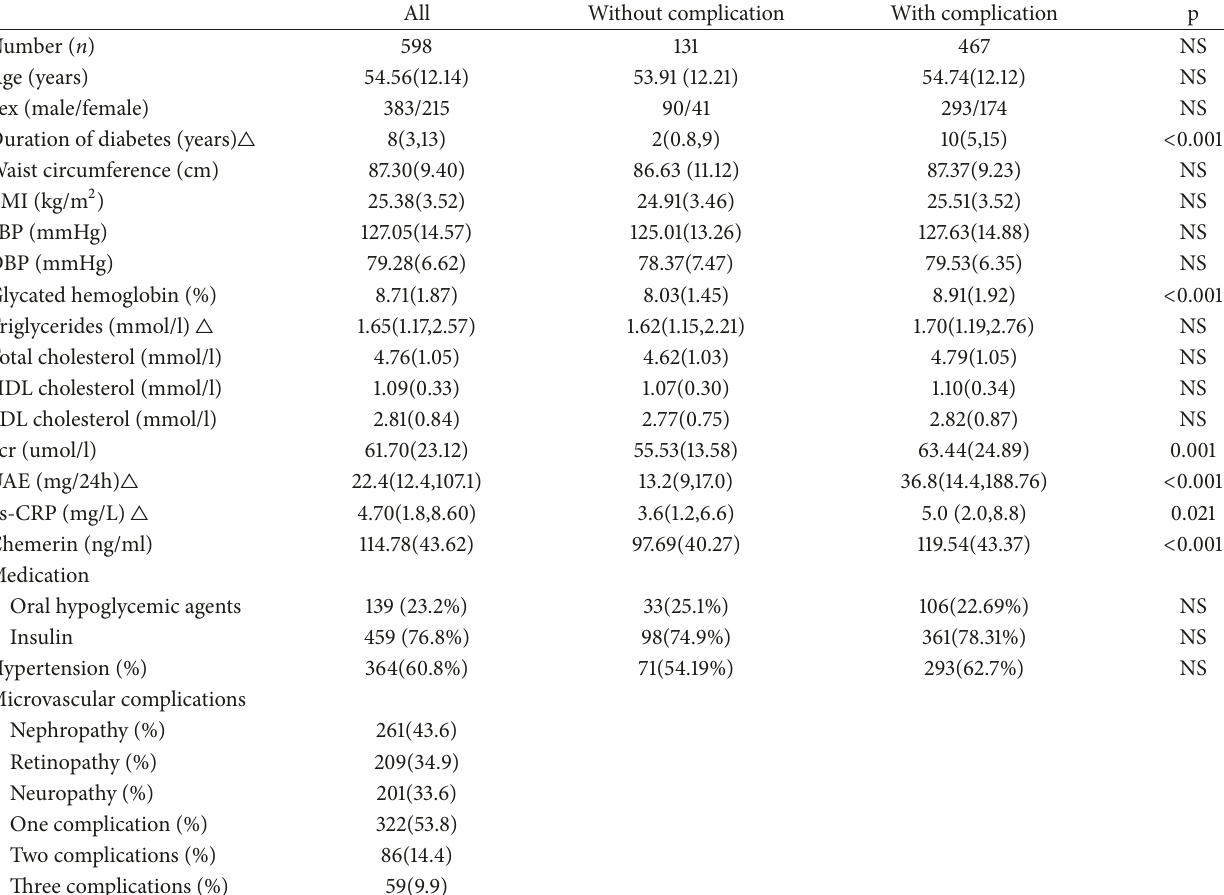
Table 1: Baseline characteristics of patients with and without microvascular complications.